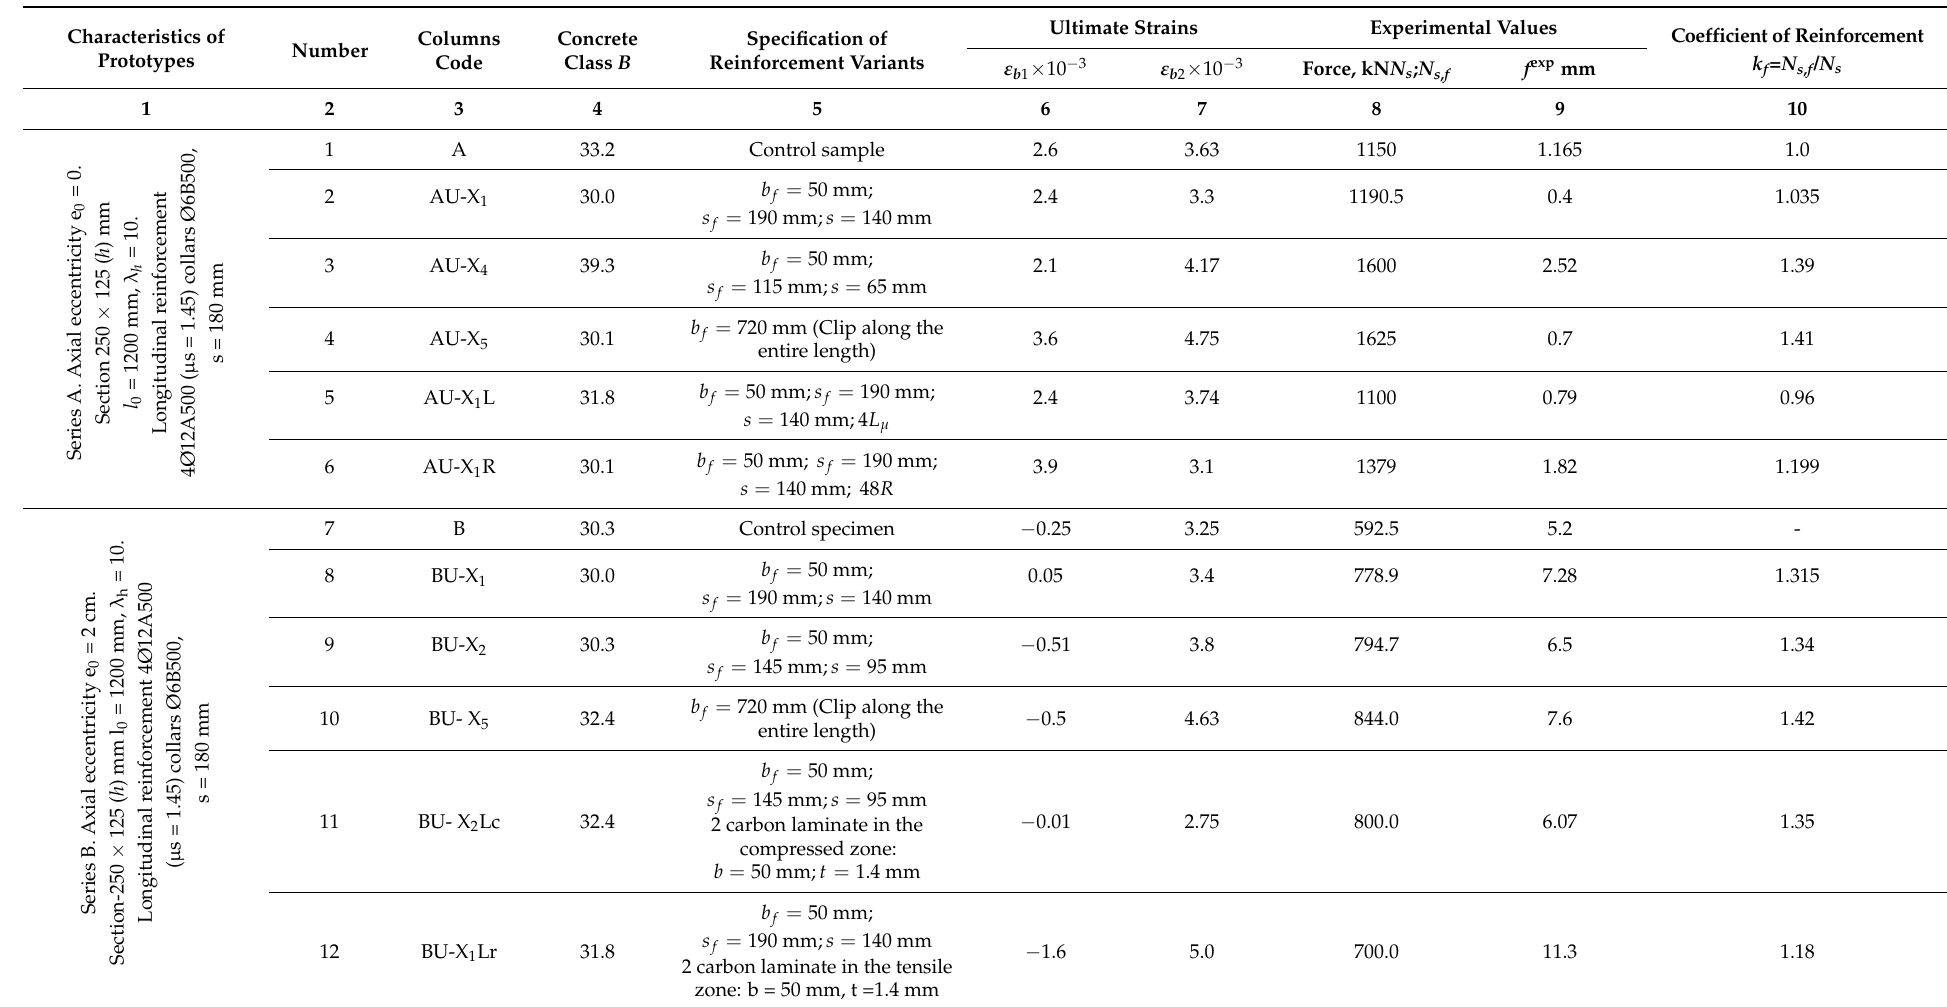
Table 4. Test results of reference and reinforced columns ( λ h = 10) with axial eccentricity of load application e 0 = 0; 2.0 and 4.0